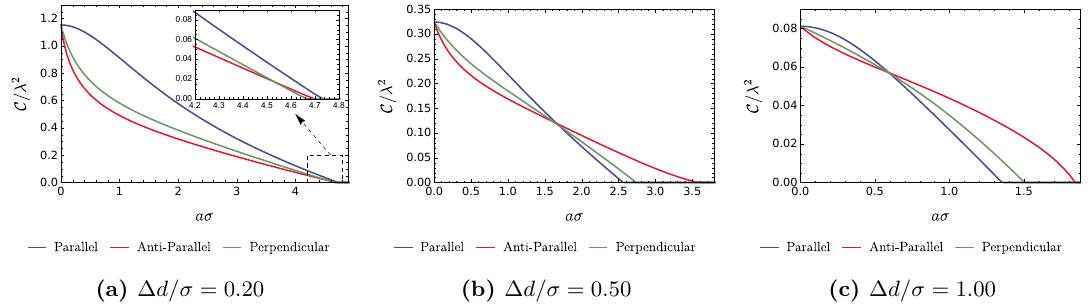
Figure 10. The concurrence C /λ 2 vs aσ for ∆ d/σ = { 0 . 20 , 0 . 50 , 1 . 00 } in the order from the left-to-right with fixed ∆ z/σ = 0 . 50 and Ω σ = 0 . 10 . In each plot, the different colored solid lines correspond to the parallel, anti-parallel and mutually perpendicular acceleration respectively. When ∆ d/σ is not too small, there seems to exist an intersection of the three curves at a nonzero aσ . However, for small ∆ d/σ , such intersecting behavior is no longer apparent (e.g., the plot of ∆ d/σ = 0 . 20 ).